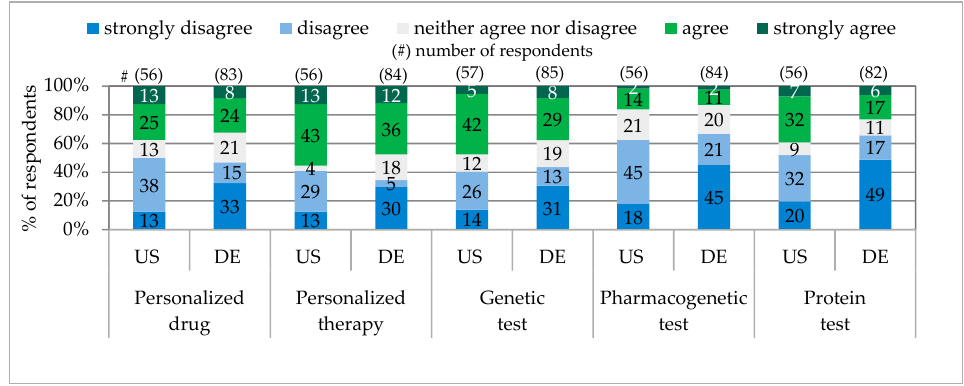
Figure 3. Physicians Prescribing and Advising Personalized Medicine.